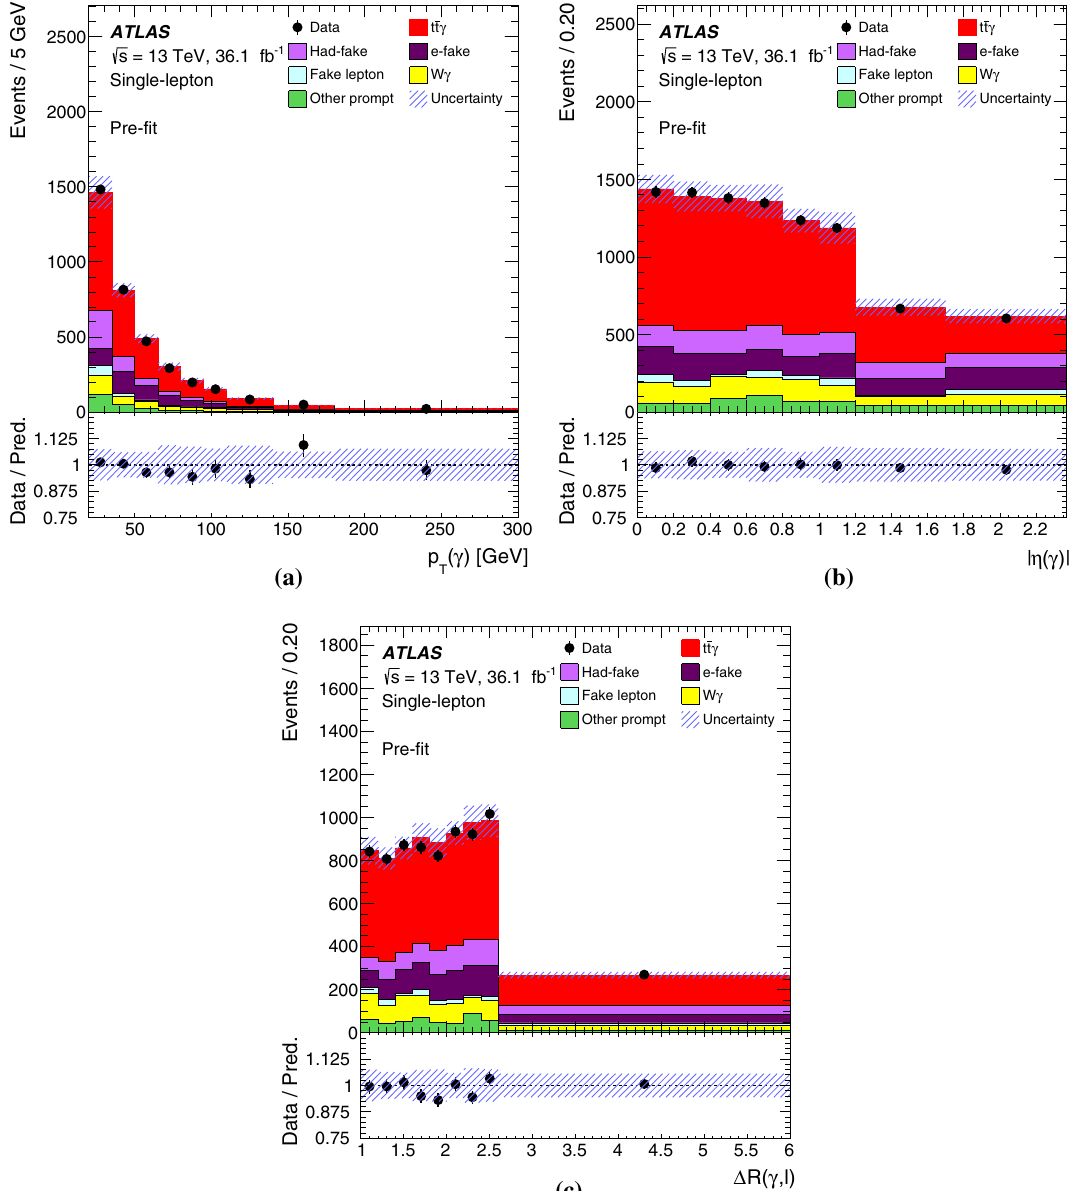
Fig. 1 Distributions of the a photon p T , b photon | η | , and c (cid:7) R (γ,(cid:8)) in the single-lepton channel after event selection and before likelihood fit. All data-driven corrections and systematic uncertainties are included. Overflow events are included in the last